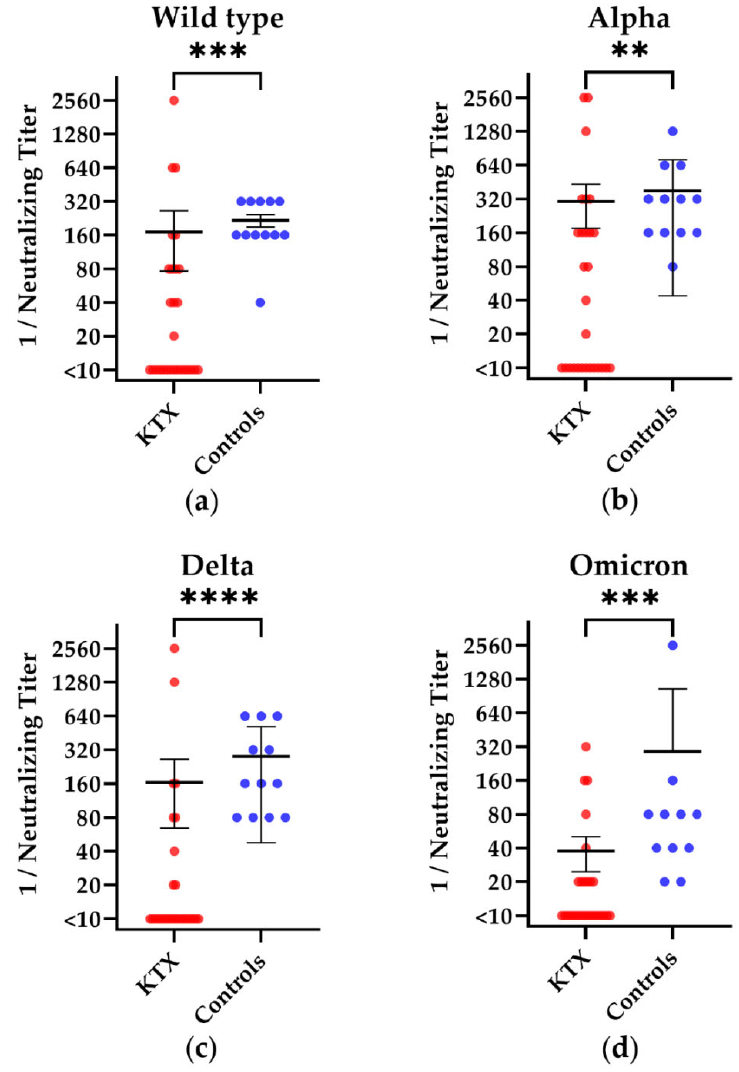
Figure 3. Titer of SARS ‐ CoV ‐ 2 ‐ specific neutralizing antibodies in kidney transplant (KTX) patients and healthy volunteers. The reciprocal of the titer of neutralizing anti ‐ SARS ‐ CoV ‐ 2 ( a )D614G (wild type), ( b ) alpha, ( c ) delta, and ( d ) omicron (BA.1) antibodies is shown on the y ‐ axis. Red circles show data of the KTX patients, while blue circles indicate data of the healthy volunteers. Two ‐ tailed Mann–Whitney tests were used to compare the responses (** p < 0.01, *** p < 0.001, **** p < 0.0001). Mean values are represented by horizontal lines, while the standard deviation is represented by error bars.